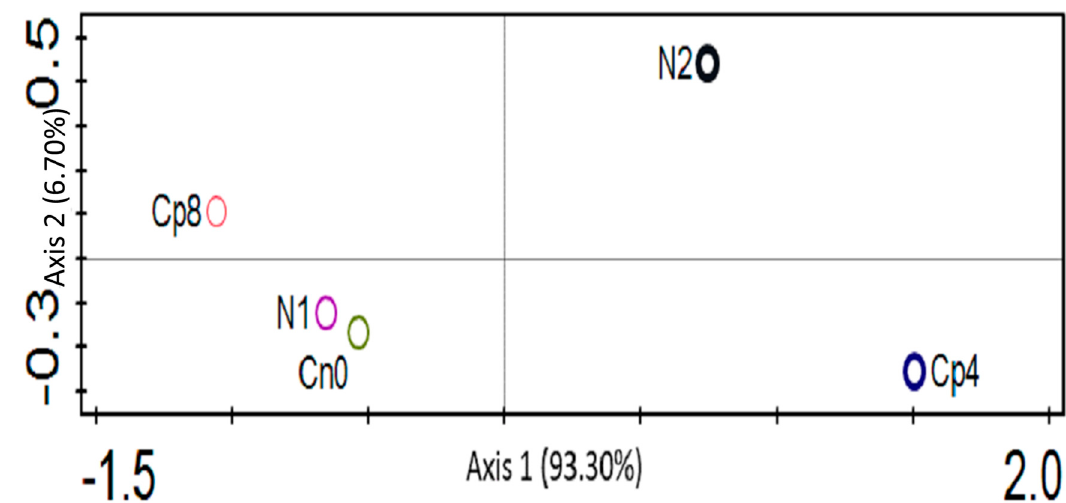
Figure 6. Principal coordinate analysis of the phosphorus cycling genes present at the rhizosphere of maize plants under fertilization and control treatments. Cp8 (8 tons/ha compost), Cp4 (4 tons/ha compost manure), N2 (120 kg/ha NPK), N1 (60 kg/ha NPK), and Cn0 (control).